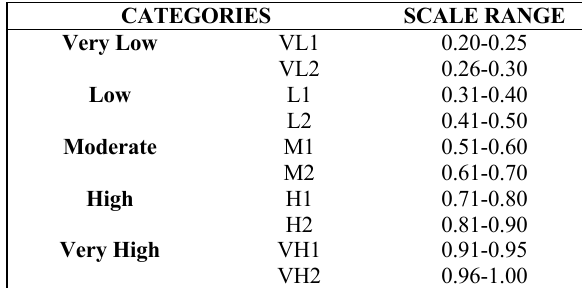
Table 1. Scale for sensitivity, exposure and vulnerability indices (Alberto et al.,